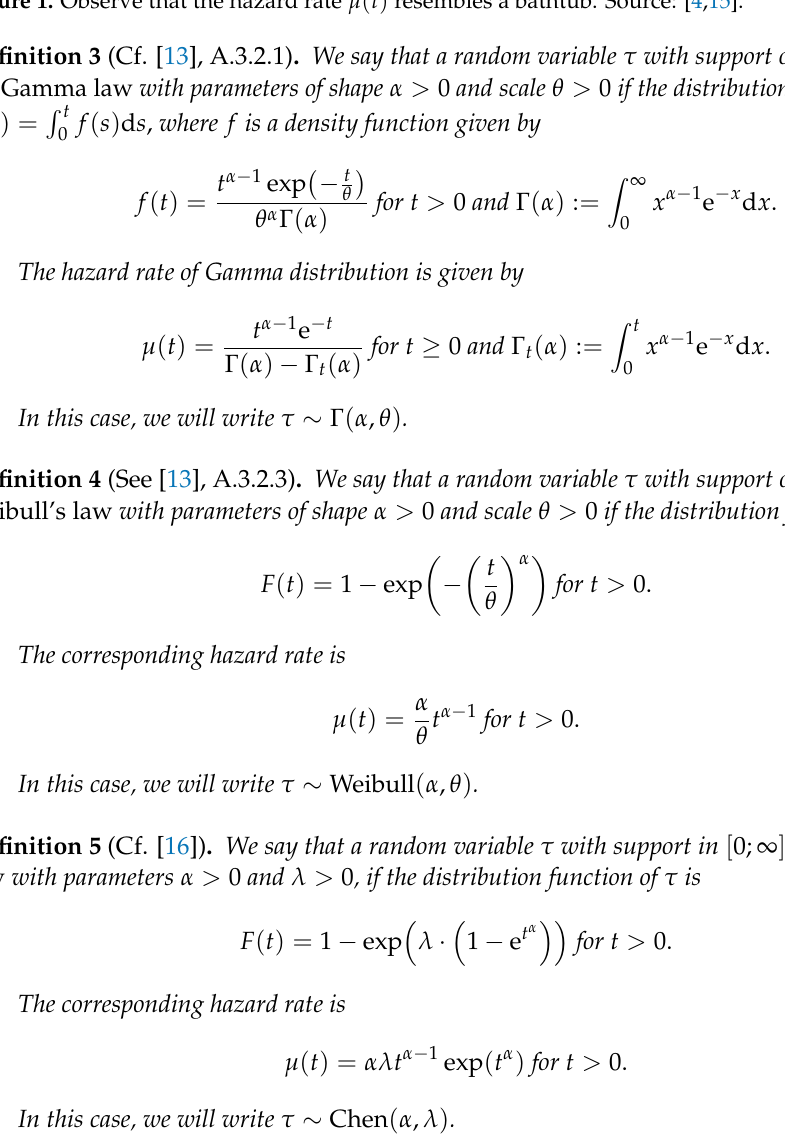
Figure 1. Observe that the hazard rate µ ( t ) resembles a bathtub. Source: